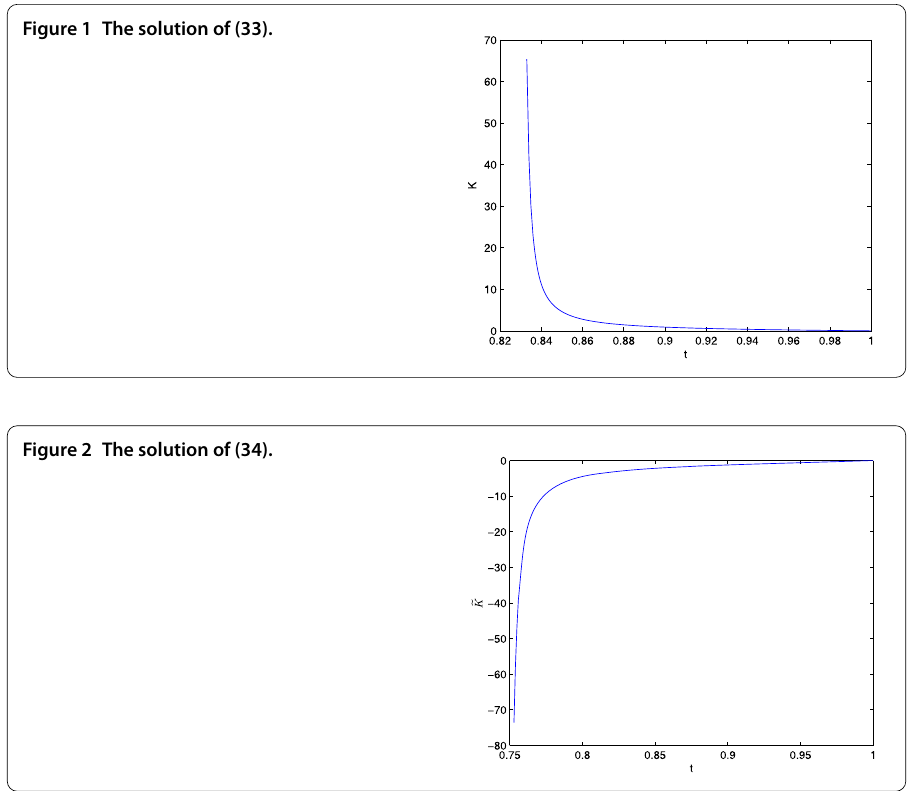
Figure 1 The solution of (33).